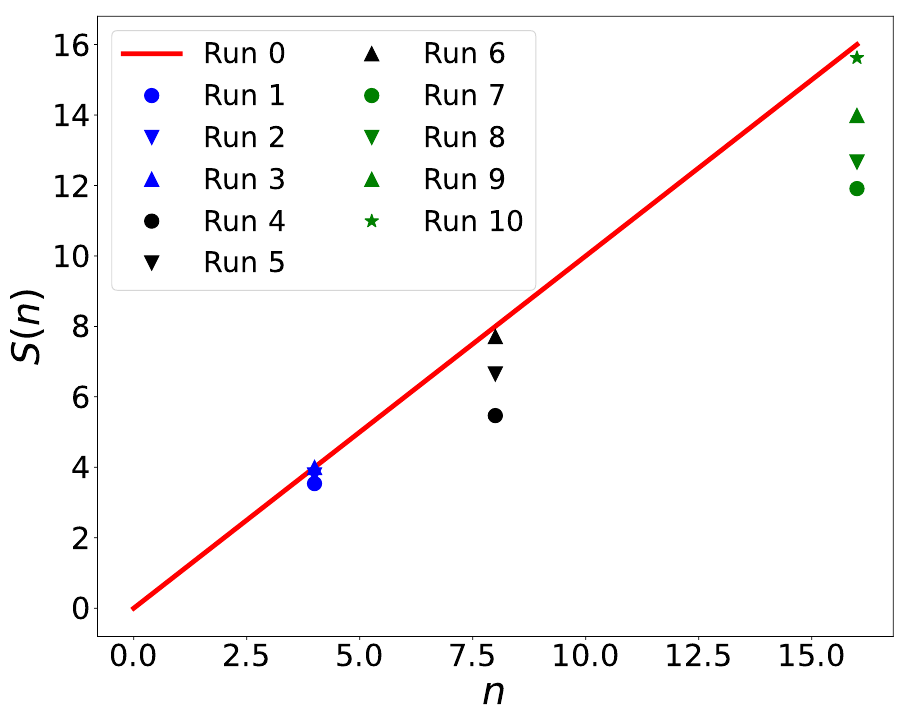
Figure 4. Comparison between the theoretical (red solid line) speed-up and the ones obtained with the different combinations of MPI/OpenMP processes/threads shown in Table